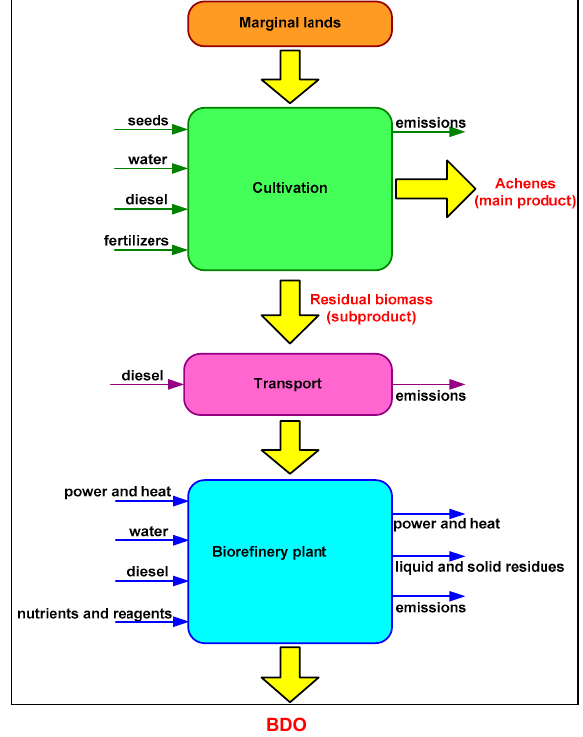
Figure 4. Boundaries of the system considered in the environmental analysis.